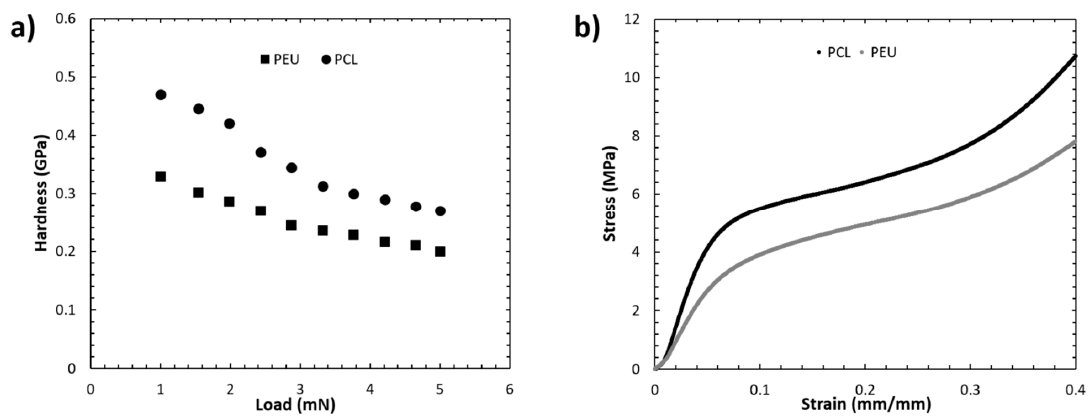
Figure 4. Mechanical data for 3D-bioprinted sca ff olds of PEU and PCL ( n = 5). ( a ) Nanoindentation data demonstrating the hardness of each sca ff old as a function of the applied load, ( b ) compression data for each sca ff old represented by stress–strain curves.